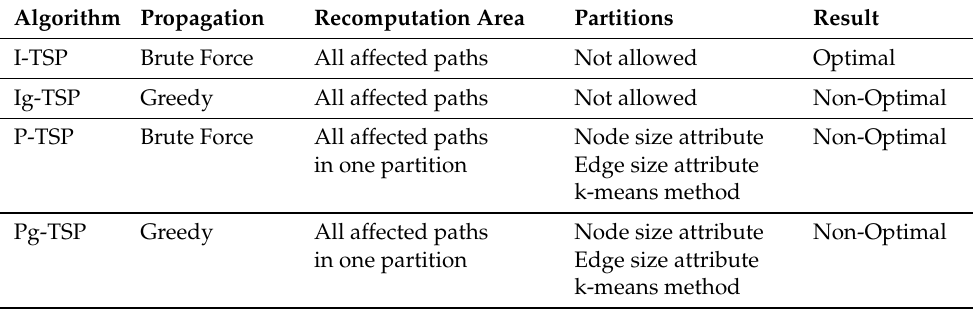
Table 4. Proposed incremental algorithms